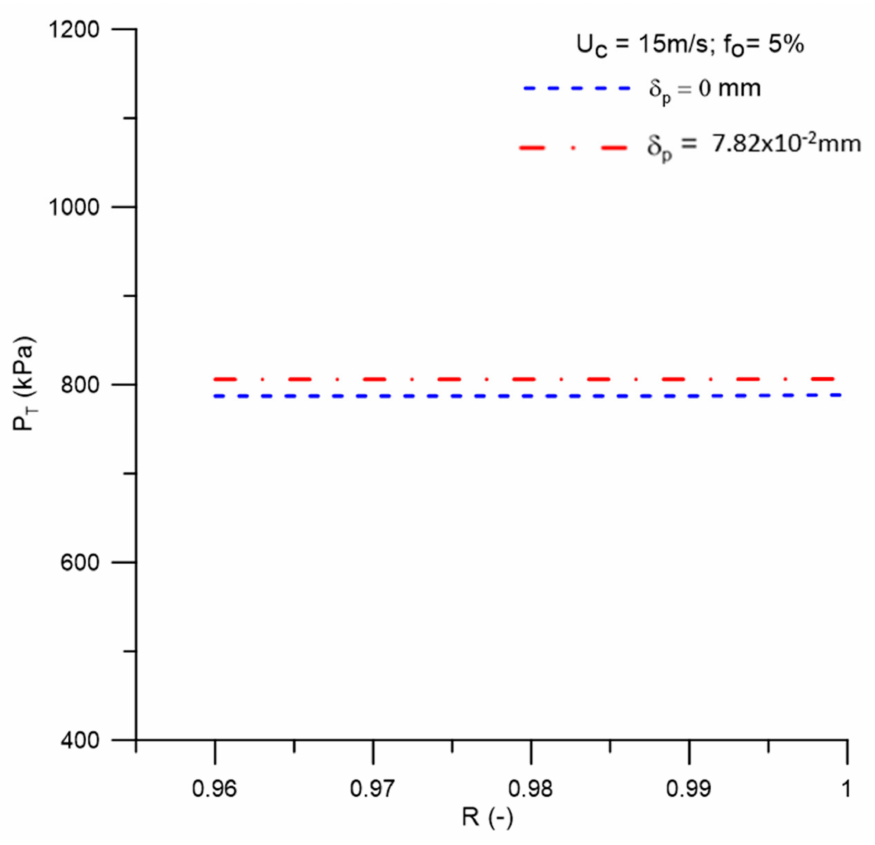
Figure 14. Transmembrane pressure behavior as a function of the membrane rejection